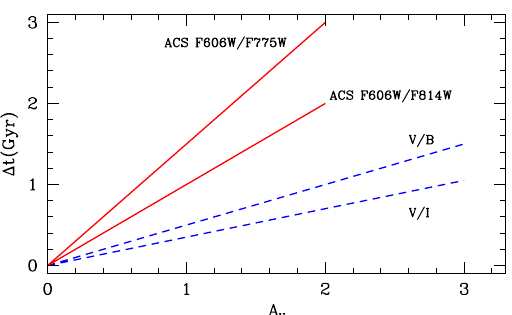
Figure 4. Bias on ages derived using isochrones accounting for T eff -dependent extinction, compared to the case of neglecting this effect, for various A V values and band